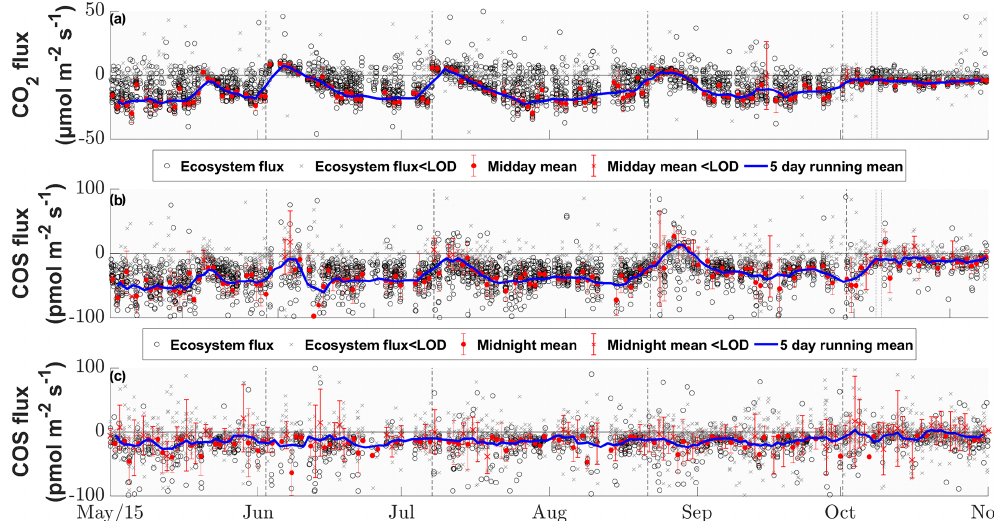
Figure 5. Seasonal cycle of the half-hourly CO 2 (a) , COS daytime (b) and COS nighttime (c) ecosystem fluxes in micromoles per square meter per second and picomoles per square meter per second, depicted by black circles if they are above the limit of detection (LOD) and gray × ’s if they are below (Langford et al., 2015). The red circles depict the mean fluxes between 11:00 and 14:00 CET for (a) and (b) and between 23:00 and 02:00 for (c) that are above the LOD, while the red × ’s indicate means below the LOD. The red error bars depict the ± 1 standard deviation of the mean. The blue lines depict the running mean (5d) for the mean fluxes. The dashed black lines depict the cuttings of the grassland.